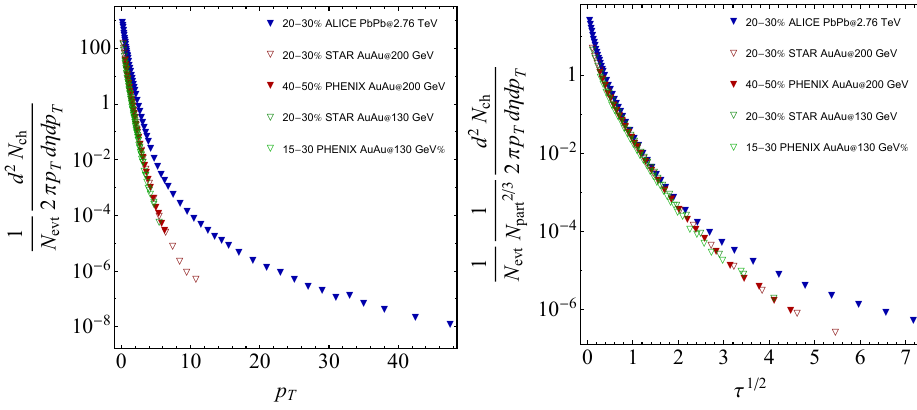
Figure 2. Illustration of geometrical scaling in heavy ion collisions at di (cid:11) erent energies for mid cen- trality classes corresponding to n part = 165 (cid:0) 186. Left panel shows charge particle distributions from ALICE [14], STAR [15, 16] and PHENIX [17, 18] plotted as functions of p T . In the right panel the same distributions are scaled according to Eq.